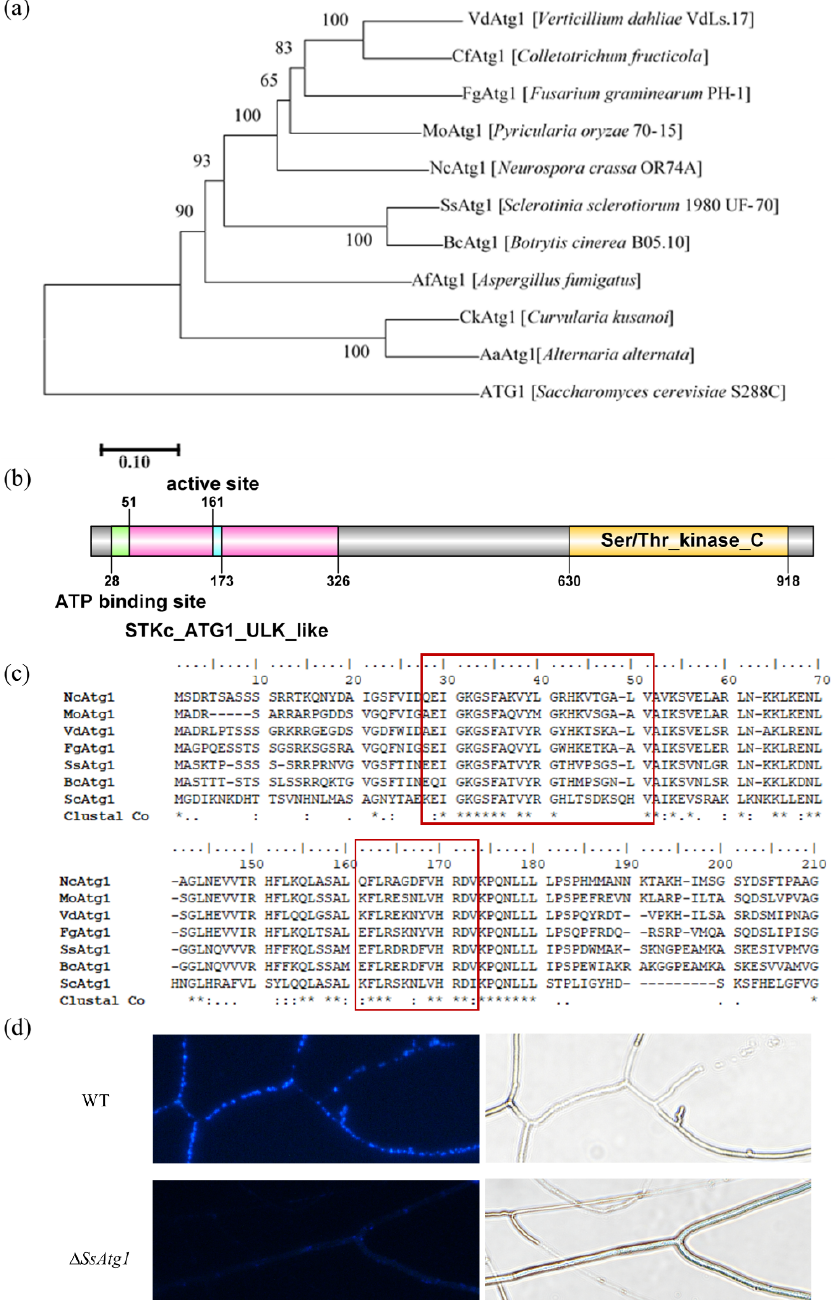
Figure 2. SsAtg1 is a key gene activating autophagy in S. sclerotiorum . ( a ) Dendrogram of SsAtg1. Mega 7.0 was used to construct the phylogenetic tree. ( b ) Sequence information of SsAtg1. The conservation of the STKc_ATG1_ULK_like (cd14009) and Ser/Thr_kinase_C (IPR022708) domains was analyzed by InterPro (http://www.ebi.ac.uk/interpro, accessed on 18 February 2022) and GPS 2.0 was used for visualization. ( c ) Alignments of the ATP binding site and active site. Clustal W was used for alignment sequences and conserved amino acids residues are labeled as *. ( d ) Autophagy analysis of ∆ SsAtg1 . MDC is a fluorescent pigment used to detect autophagosome formation. Scale bar = 10 µ